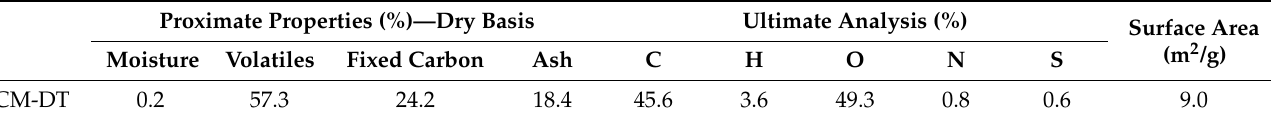
Table 4. The proximate analysis and ultimate analysis of CM-DT.